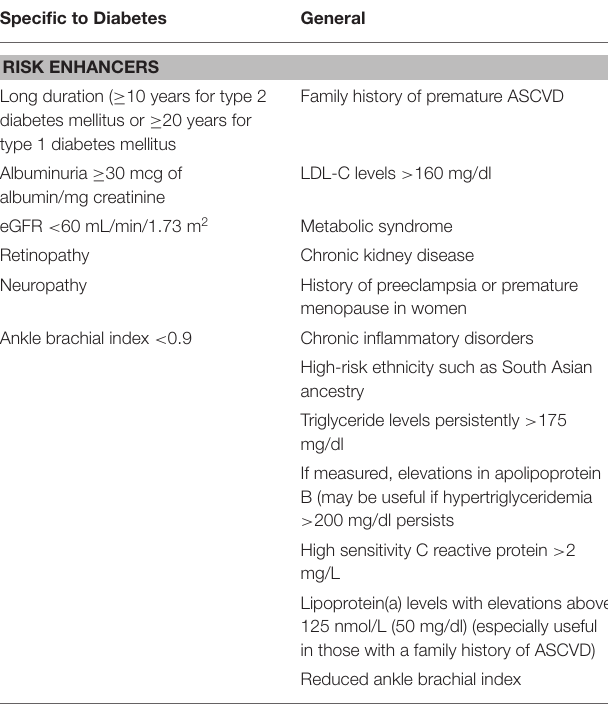
TABLE 2 | Risk enhancers for atherosclerotic cardiovascular disease (ASCVD) (14). Specific to